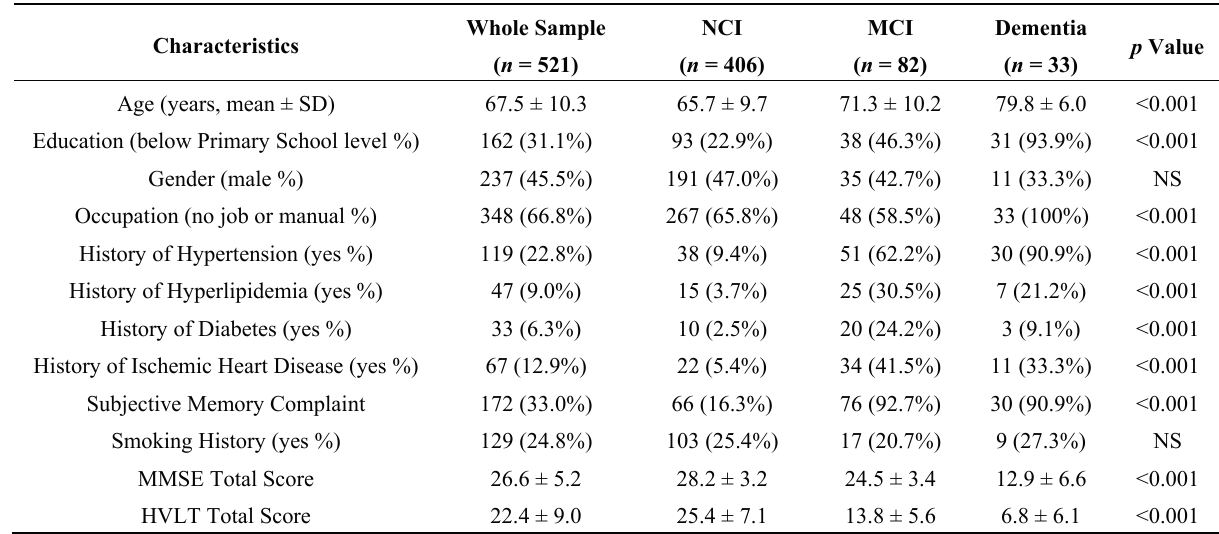
Table 1. Descriptive characteristics of study participants.